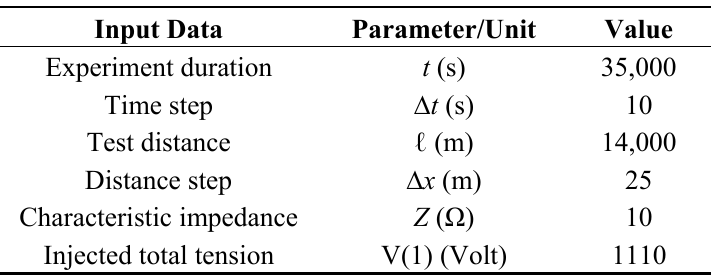
Table 2. TLM input